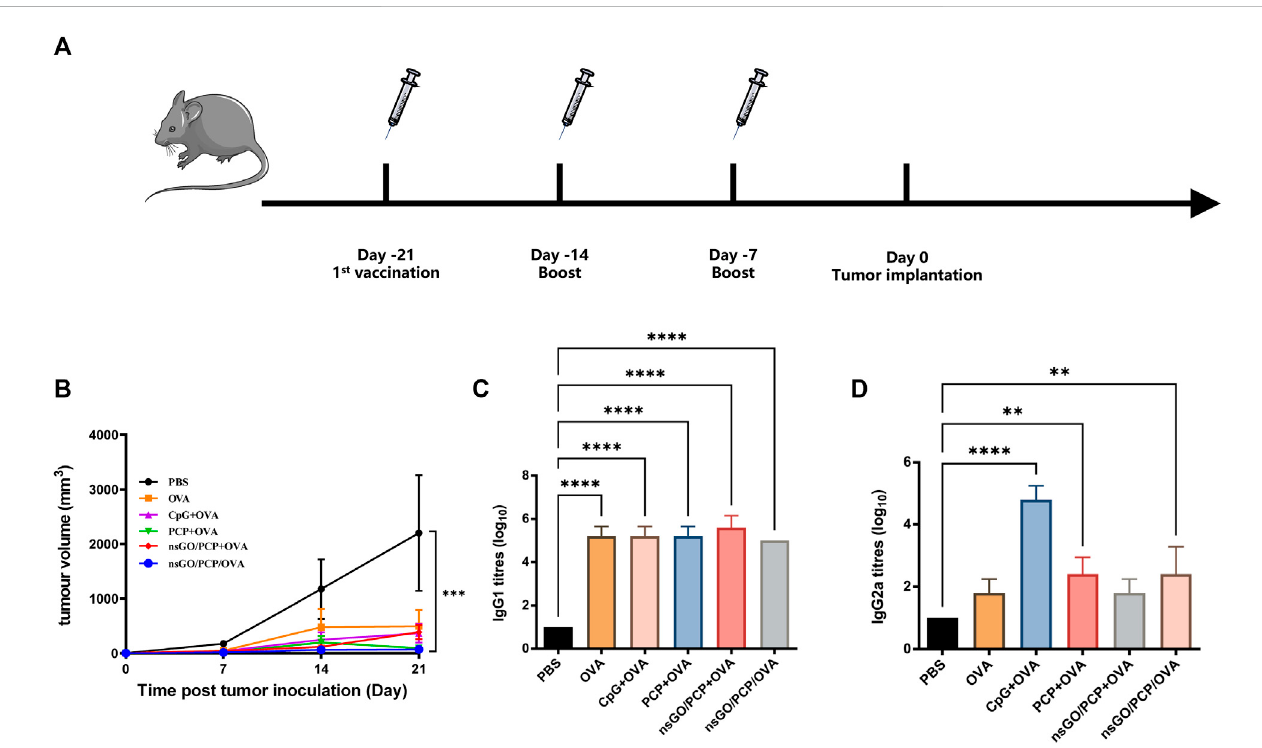
FIGURE 5 Prophylactic anti-tumor effects of nsGO/PCP/OVA on mice. (A) Immunization scheme for tumor prevention. Mice were primed subcutaneously with either PBS, OVA, CpG + OVA, PCP + OVA, nsGO/PCP + OVA, or nsGO/PCP/OVA and boosted with the same antigens twice at 1 week intervals. On day 0, 2 × 10 5 (E) G7-OVA cells were injected subcutaneously into the right fl ank of mice. (B) On day 21, mice were sacri fi ced and tumor masses were measured. Blood was collected on day 21. The concentrations of OVA-speci fi c IgG1 (C) and IgG2a (D) secretions in mouse serum were measured by ELISA. Data are presented as means ± SD (n = 5), **, p < 0.01; ****, p < 0.0001 vs. PBS